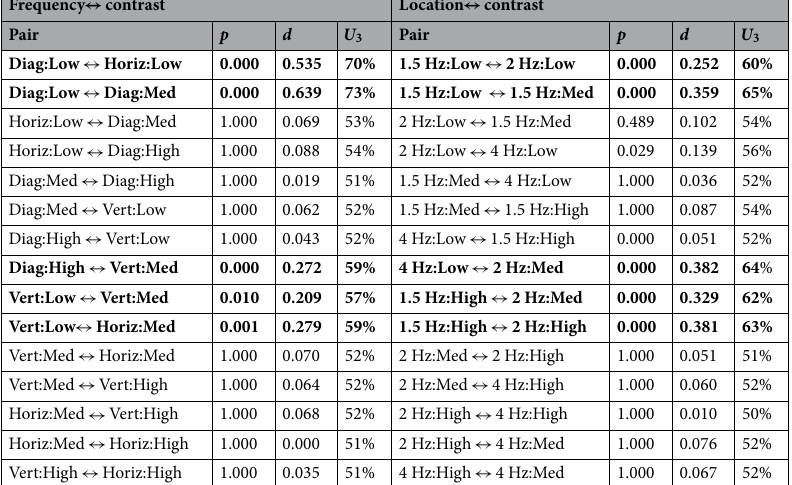
Frequency ↔ contrast Location ↔ contrast